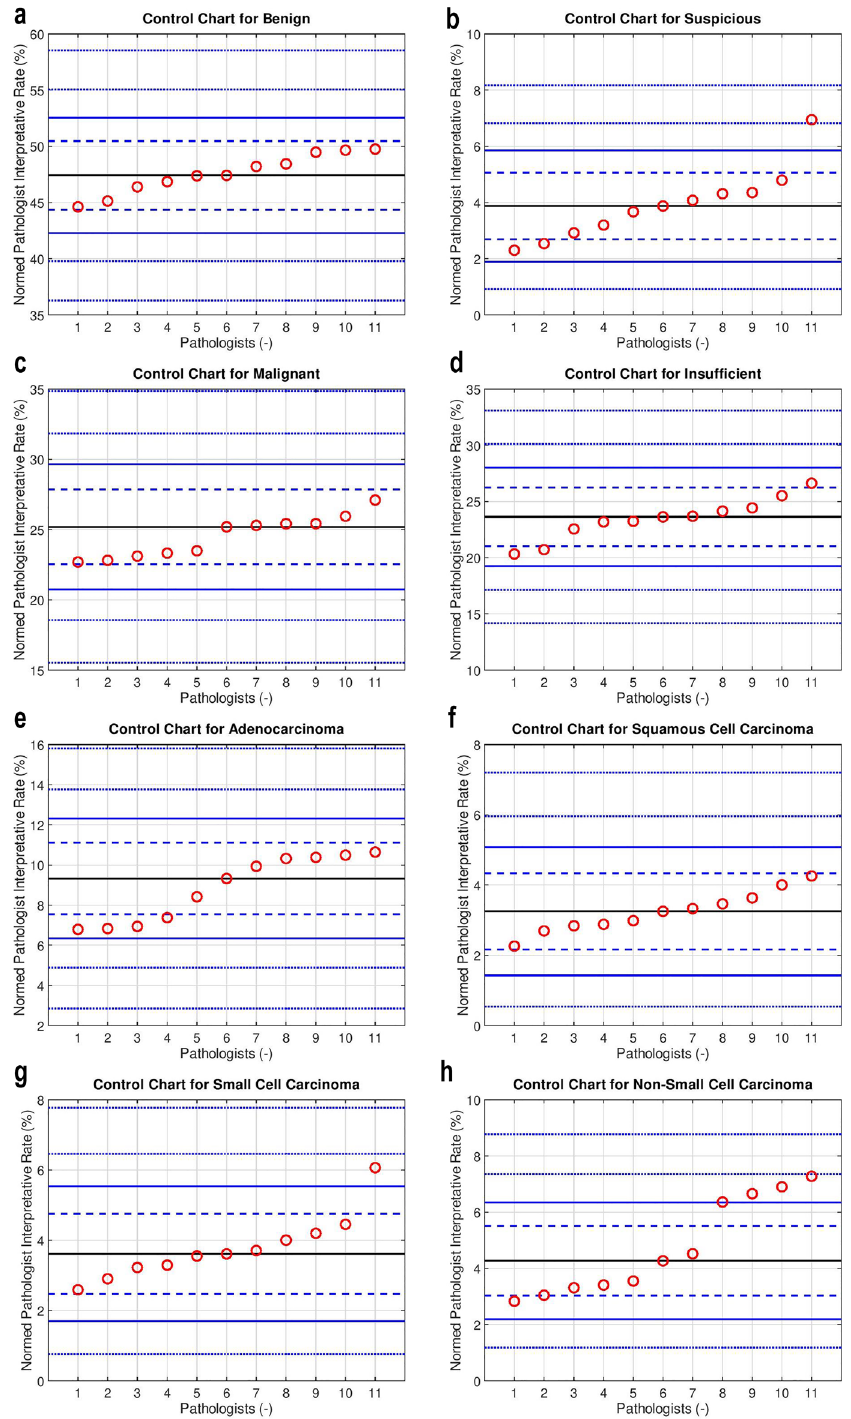
Figure 1. Pathologist control charts for the mutually exclusive diagnostic categories (( a ) benign, ( b ) suspicious, ( c ) malignant, ( d ) insufficient), and the main subtypes of cancer (( e ) adenocarcinoma, ( f ) squamous cell carcinoma, ( g ) small cell carcinoma, ( h ) non-small cell carcinoma. The red circles represent individual pathologists. Pathologists are ordered by the normalized diagnostic rate. The black line in the centre of the control chart is the group median diagnostic rate (GMDR). The dashed blue (control) lines represent the boundaries of the 95% confidence interval (CI) and correspond to p = 0.05. The solid blue (control) lines represent the boundaries of the 99.9% CI and correspond to p = 0.001. The dashed blue (control) lines beyond the solid blue line represent the p = 1e-6 and p = 1e-12 respectively. Details of the normalization are in Appendix A. It should be noted that: each control chart is sorted by the rate; pathologist #1 on one chart is generally not pathologist #1 on any other